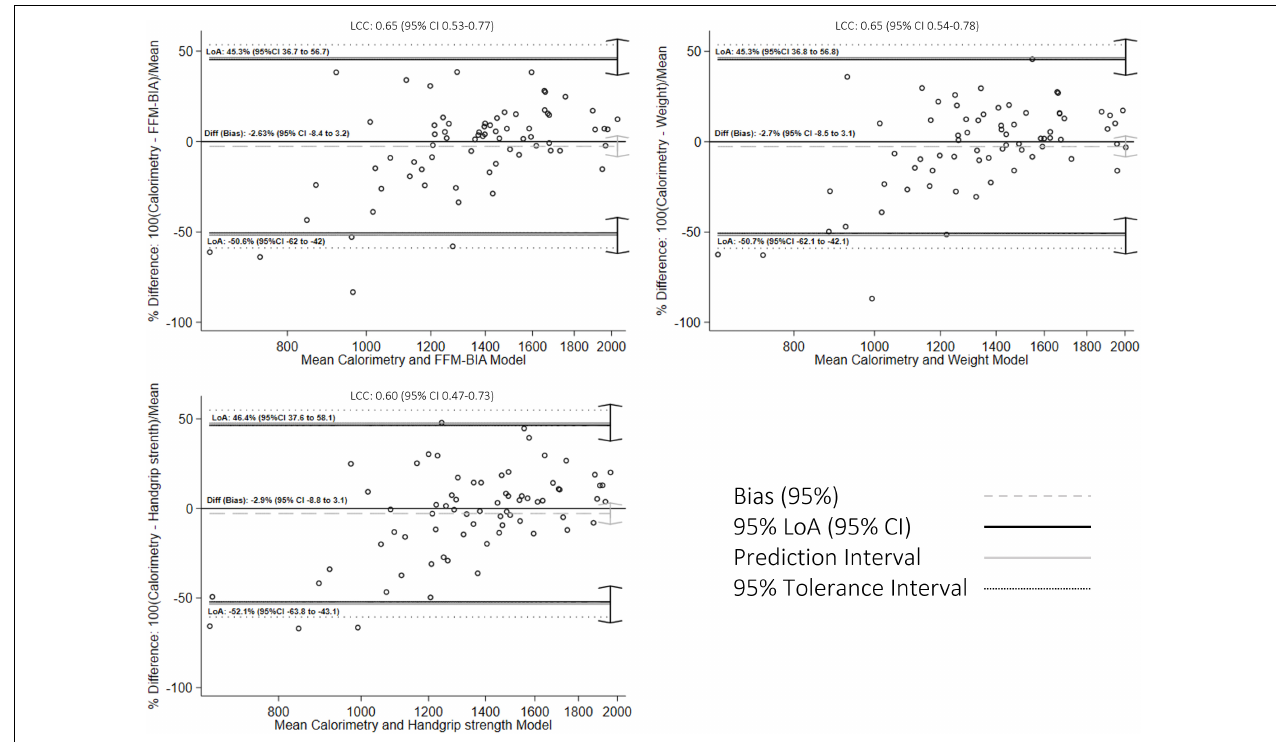
FIGURE 2 | Bland-Altman graph for concordance analysis between fitted values and indirect calorimetry